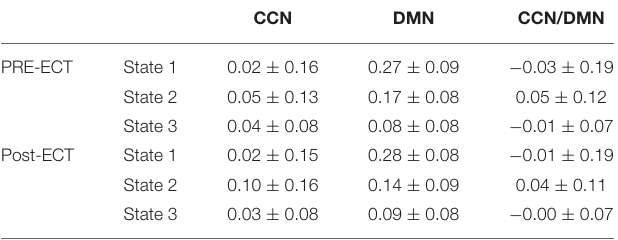
TABLE 3 | The state-specific dFNC